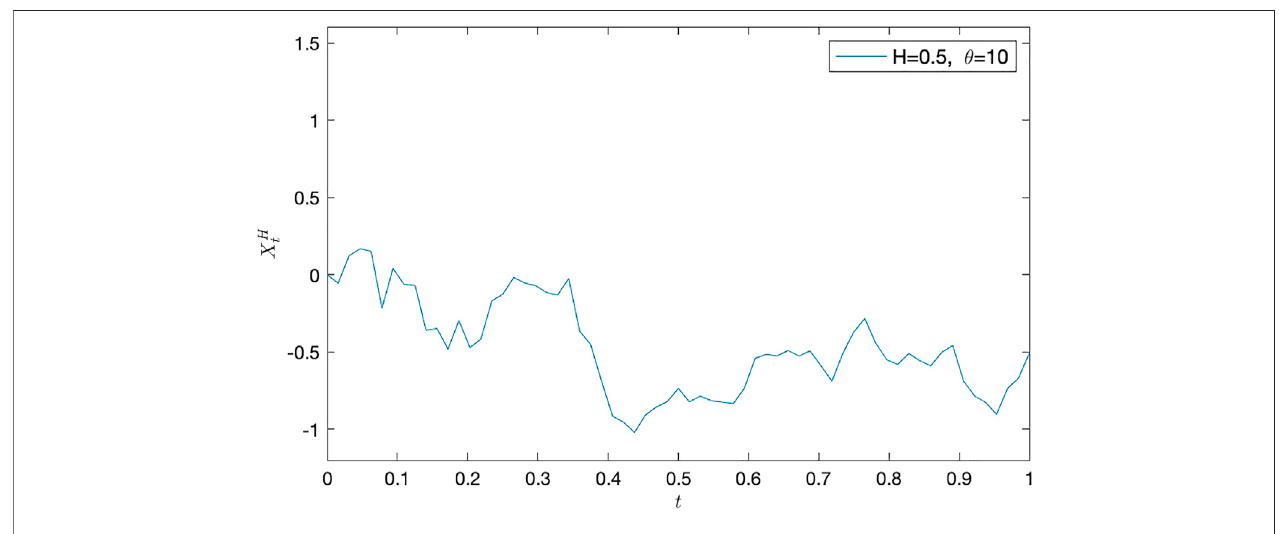
FIGURE 5 | Path of X H with θ (cid:1) 10 and H (cid:1) 0.5.